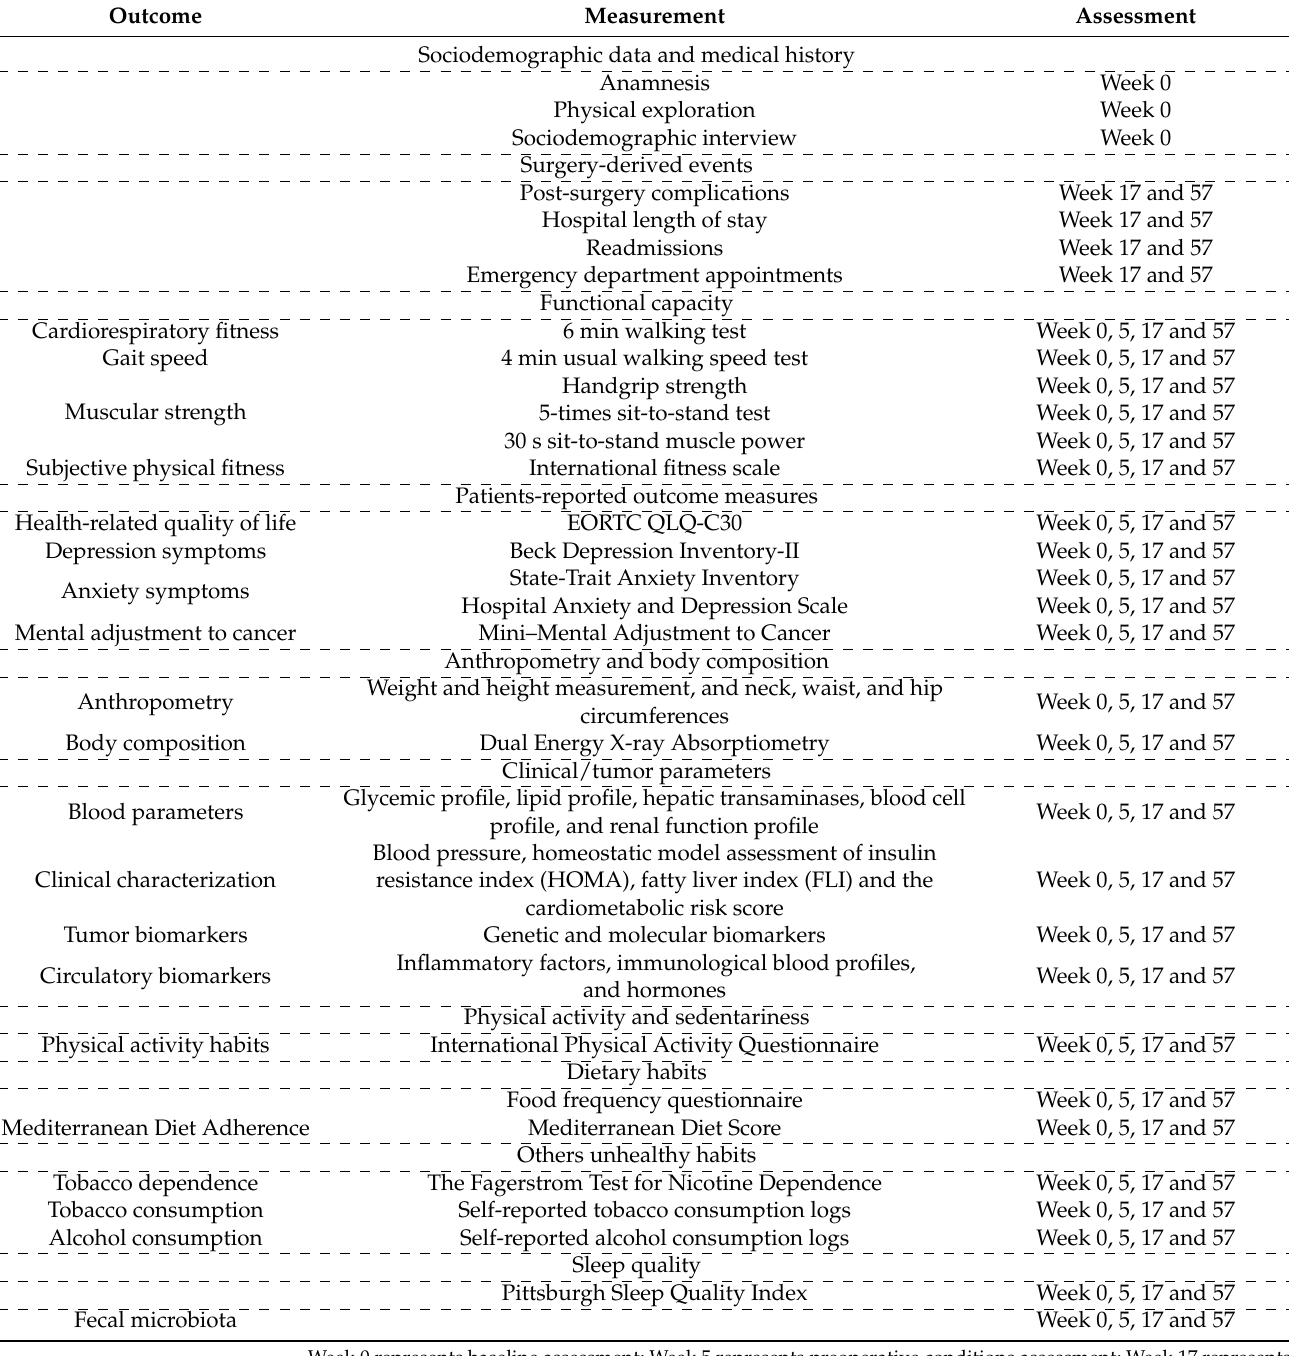
Table 2. ONCOFIT study endpoints, measurements, and